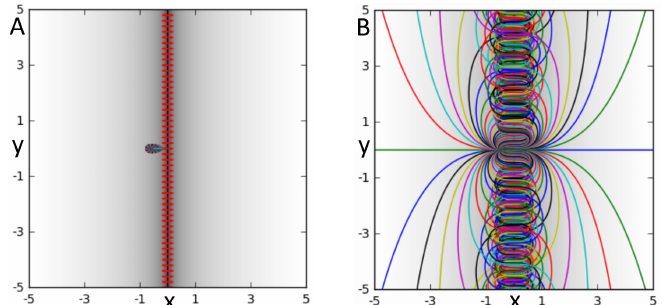
Figure 12: Null geodesic trajectories for the linear dreibein wall, with m ( x ) = x . A: Geodesics launched near the wall of singularities. The singular manifold has been labeled with collimation arrows. B: The long-time geodesic dynamics. Note that all geodesics are in permanent bound states along the singular wall, see Eq. (66). All crossings of the singular wall occur at the collimation angle θ ∗ = 0 (or π